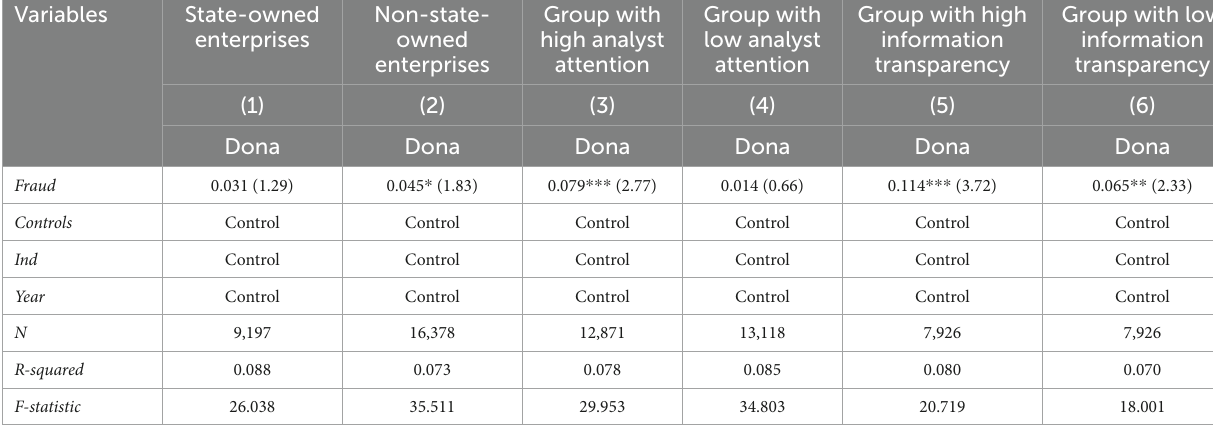
TABLE 6 Corporate violation and charitable donation: grouping regressions.